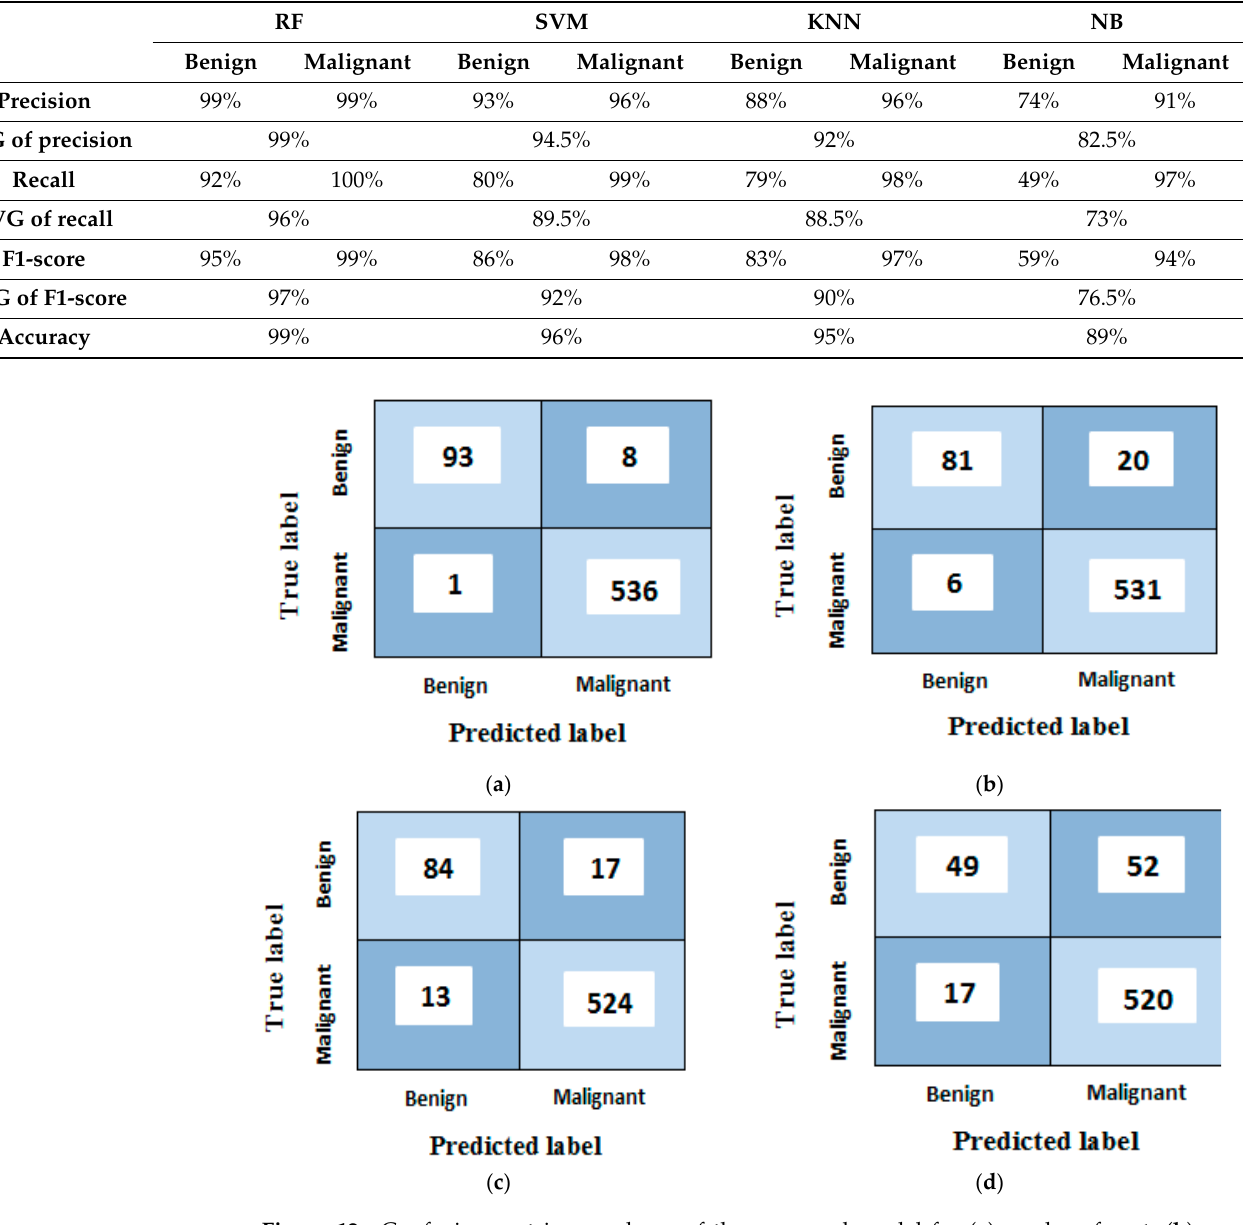
Figure 12. Confusion matrices analyses of the proposed model for ( a ) random forest, ( b ) support vector machine, ( c ) k ‐ nearest neighbor and ( d ) naïve Bayes classifiers before using grey wolf optimization algorithm.